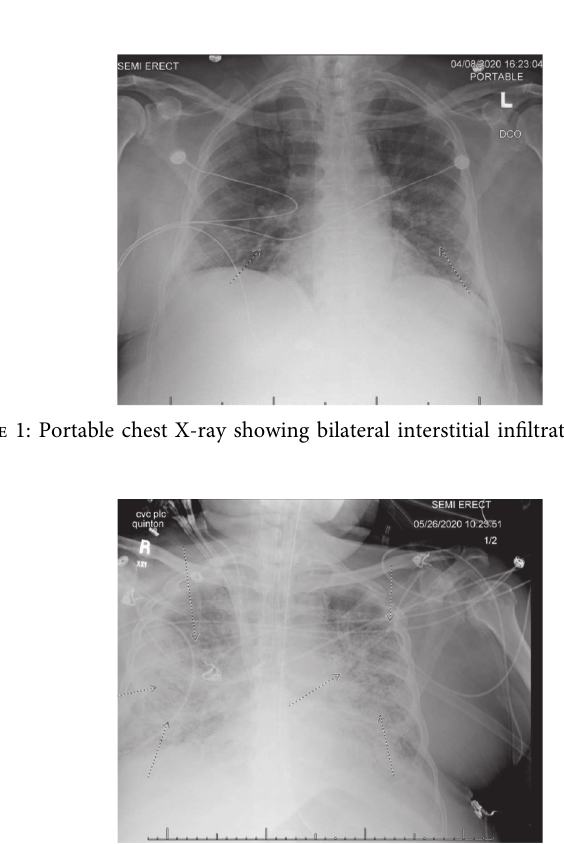
Figure 2: Portable chest X-ray with lungs demonstrating extensive diffuse infiltrates with worsening aeration from the prior chest X-ray.